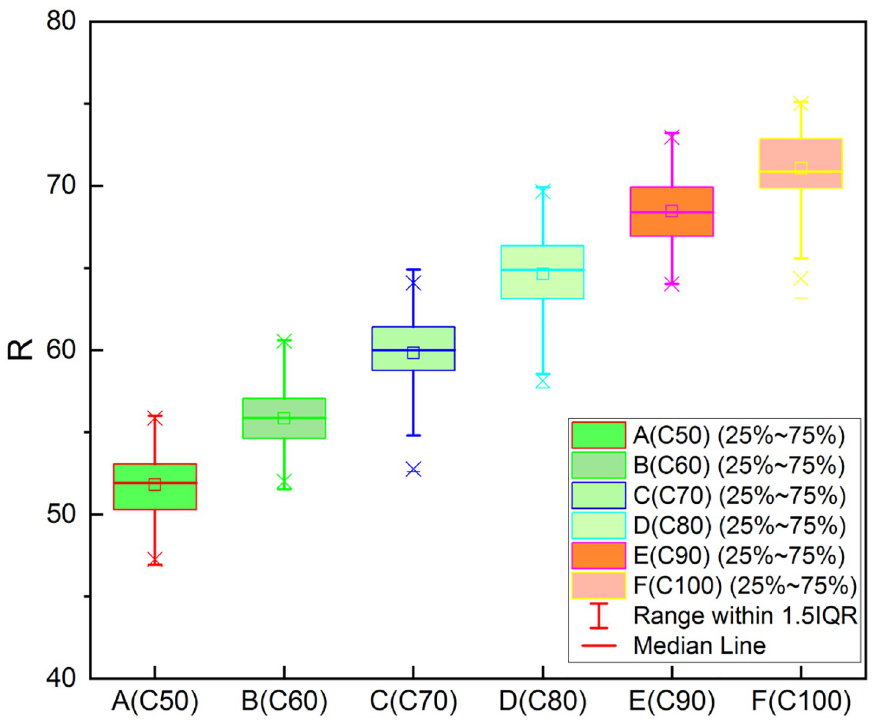
Fig 6. Boxplot of experimental data